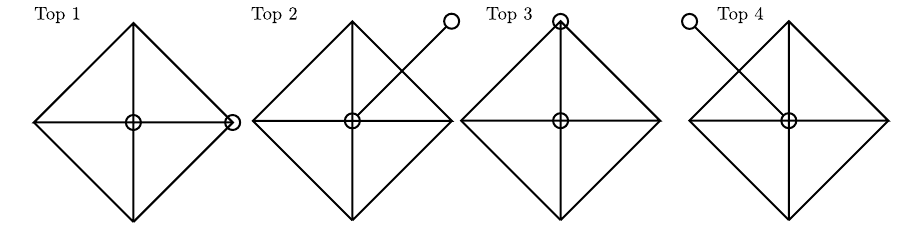
Figure 1 . The toric diagram of the four inequivalent SU(2) tops over F 2 .